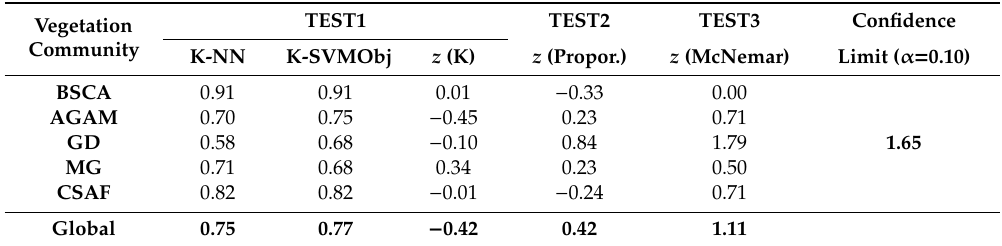
Table 6. Test results for the object-based classification, as a comparison of NN and SVMObj. For abbreviations, see main text.